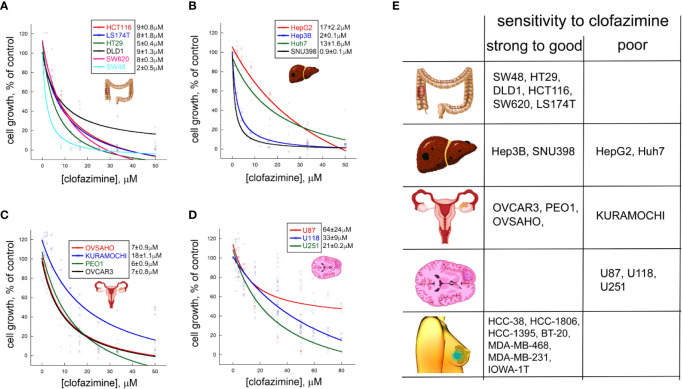
Different sensitivities to growth inhibitionl by clofazimine are revealed on a large panel of cancer lines from four distinct cancer types. Concentration-dependent decrease in cell proliferation in the MTT assay is seen for six colorectal cancer (CRC) lines (A), four hepatocellular carcinoma (HCC) lines (B), four ovarian cancer (OC) lines (C), and three glioblastoma lines (D). The curves are built on three to ten replicates for each tested clofazimine concentration. The calculated IC50 values are provided next to each cell line’s name as mean ± sem, n = 3 to 8). (E) Based on the IC50 values, and adding the data on seven TNBC lines previously published by us, a chart is created with the cell lines grouped into those having strong (IC50 ≤ 2 µM) to good (IC50 < 10 µM) sensitivity to clofazimine and those having poor (IC50 > 10 µM) sensitivity. A general picture emerges that TNBC, CRC, and subsets of HCC and OC, but not glioblastoma, lines has good to strong sensitivity to the drug.